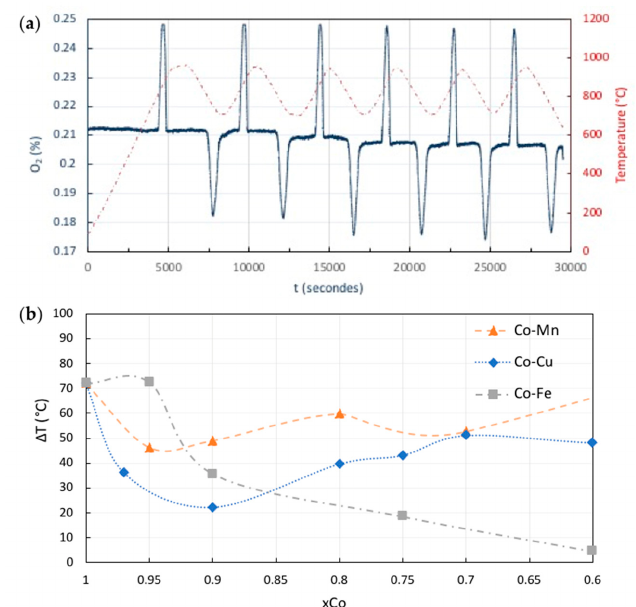
Figure 7. ( a ) Redox activity of Co 3 O 4 /CoO foam made from commercial Co 3 O 4 , ( b ) variation of the